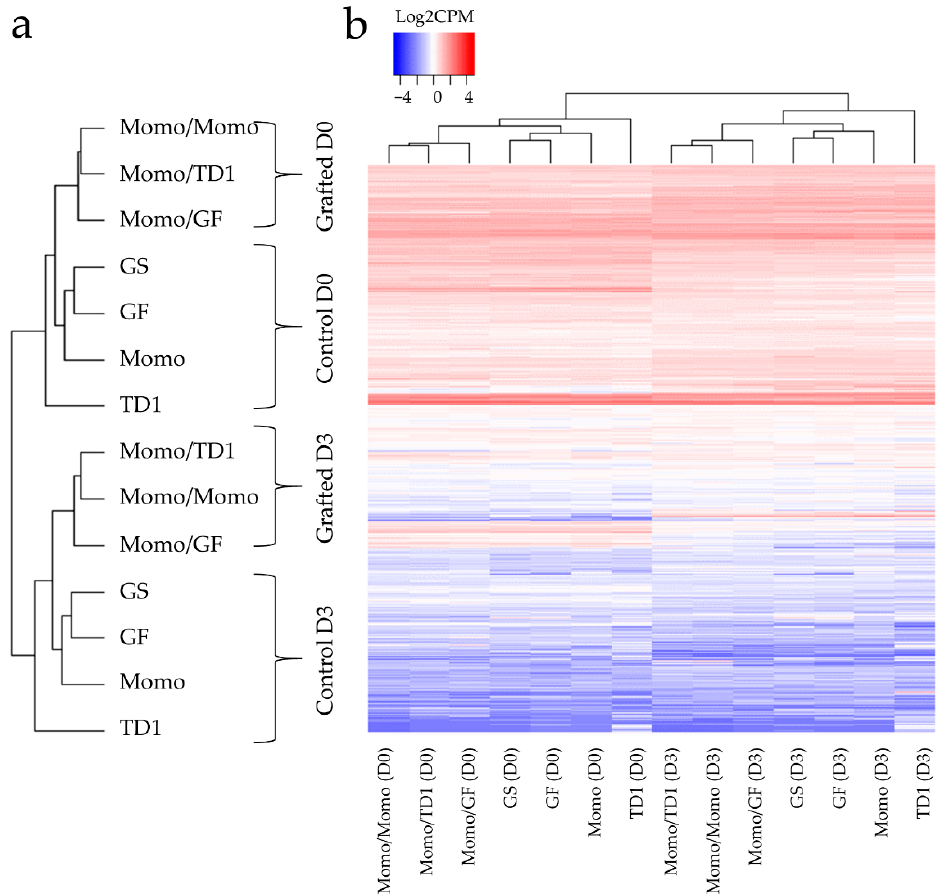
Figure 2. Control and grafted tomato lines show different gene expression pattern under normal and stress conditions. ( a ) Dendrogram of control and grafted tomato lines under D0 and D3. Brackets indicated sample lines that were grouped as control and grafted, and D0 and D3. ( b ) Heatmap of the gene expression in logarithm counts per million (Log 2 CPM) of the different grafted combinations and non-grafted tomato lines. Red and blue indicate high and low expressions, respectively. Top brackets group the gene expression similarities between tomato lines. D0 and D3 indicates before drought stress and day 3 during drought stress treatment.